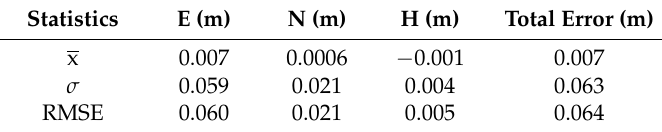
Table 4. Mean (x), Standard deviation ( σ ) and RMSE of GCP estimation after bundle adjustment.